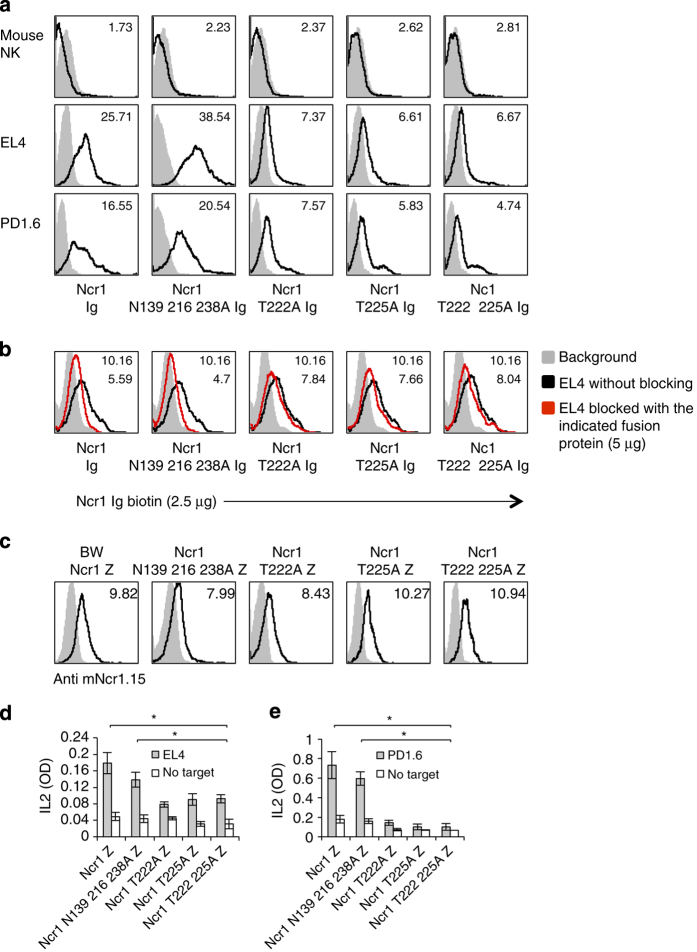
The O-linked glycosylations of Ncr1 are important for its function against various tumors. (a) FACS staining of murine cell lines and primary NK cells, as indicated. Staining was performed with various Ncr1 Ig fusion proteins (listed in the bottom of the figure, black line histograms). The gray filled histograms are the backgrounds secondary mAb staining. The median fluorescent intensities (MFIs) of the fusion proteins staining are indicated. (b) FACS staining of EL4 cells that were untreated or blocked with the indicated fusion proteins. The cells were then stained with biotinilated Ncr1 Ig. The gray filled histograms are the backgrounds secondary mAb staining of the unblocked EL4 cells. The blocked EL4 cells background was identical to the unblocked and is not shown in the figure. The MFIs of the fusion proteins staining are indicated. (c) FACS staining of BW transfectants expressing the various Ncr1 proteins, as indicated. Staining was performed with anti-mNcr1.15 mAb (black line histograms). The gray filled histograms represent the background staining with the secondary anti-mouse antibody. MFIs of the anti-Ncr1 mAb staining are indicated. (d, e) IL2 secretion from the various BW transfectants presented in (c) following 48-h incubation with murine EL4 (d) and PD1.6 (e) cells. Values are shown as mean ±s.e.m. *P<0.05. The entire figure represents data collected from three independent experiments of each assay.